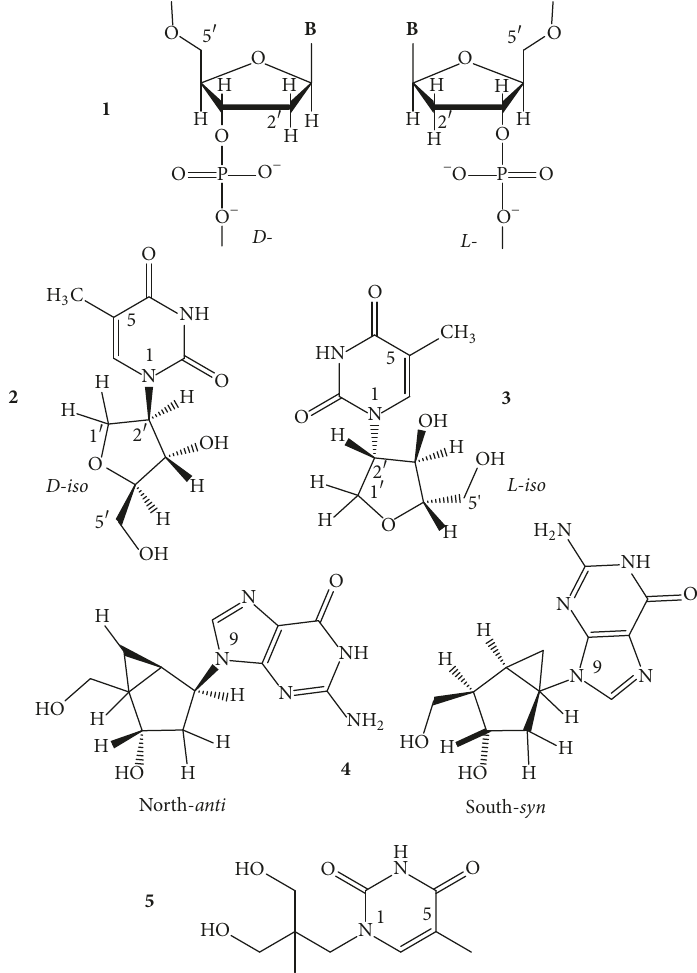
Figure 11: The mirror image D- and L-2 󸀠 -deoxynucleosides ( 1 ); the D- ( 2 ) and L- iso -thymidines ( 3 ); the anti north- and the syn south- bicyclo[ 3 . 1 .0]hexane-dGs ( 4 ); and an acyclic thymine analog, the N 1 -(3-hydroxy-2-hydroxymethyl-2-methylpropyl)-thymine ( 5